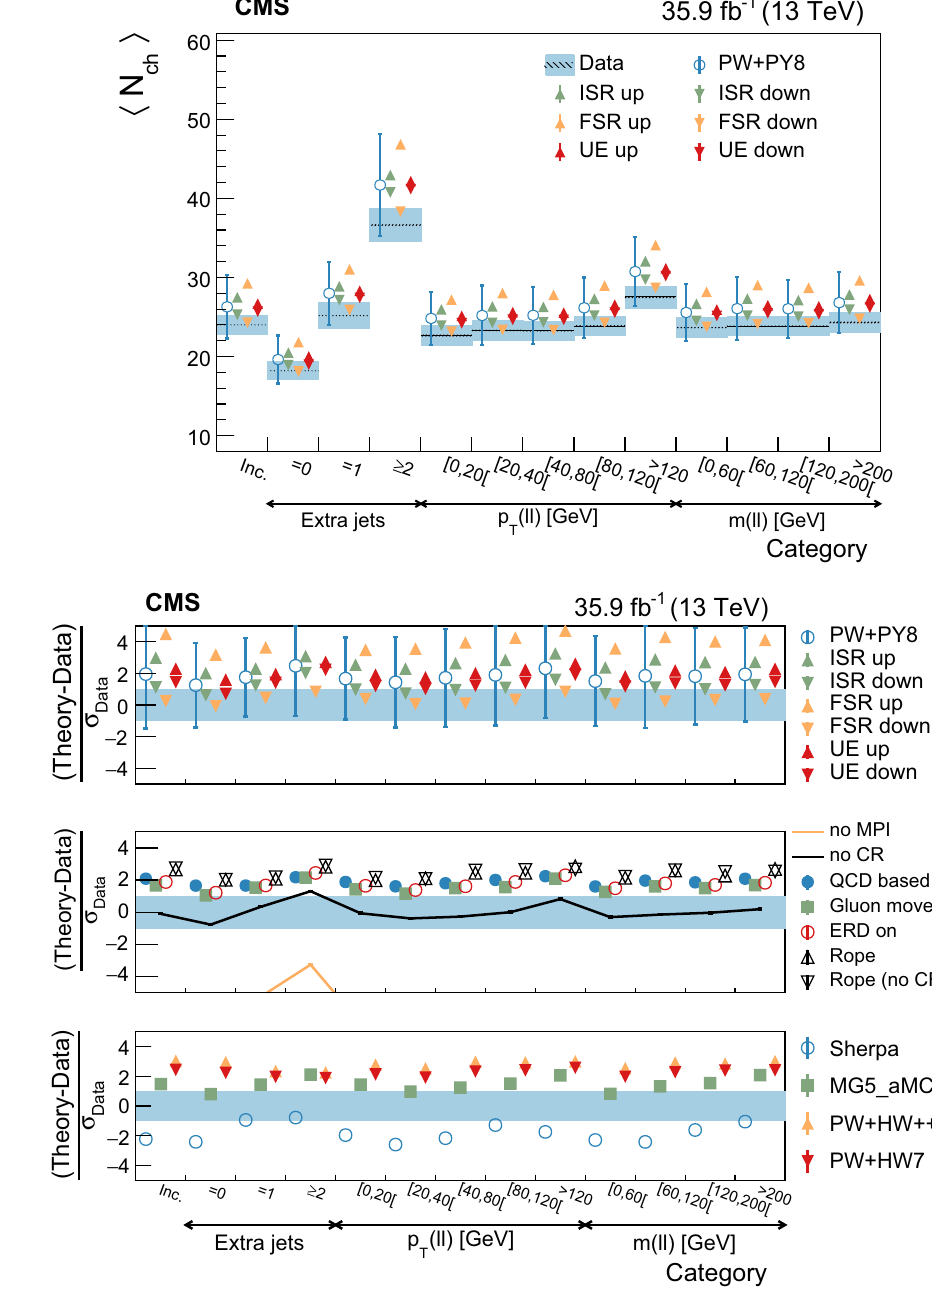
Fig. 14 Average N ch in different event categories. The mean observed in data (boxes) is compared to the predictions from different models (markers), which are superimposed in the upper figure. The total (statistical) uncertainty of the data is represented by a shaded (hatched) area and the statistical uncertainty of the models is represented with error bars. In the specific case of the Pw+Py8 model the error bars represent the total uncertainty (see text). The lower figure displays the pull between different models and the data, with the different panels corresponding to different sets of models. The bands represent the interval where | pull | < 1. The error bar for the Pw+Py8 model represents the range of variation of the pull for the different configurations described in the